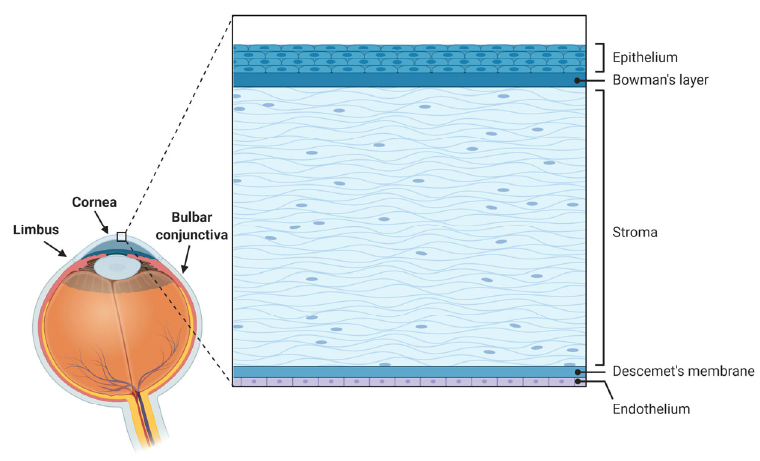
Figure 1. Anatomy of the ocular surface and histology of the human cornea and its various layers. Corneal healing, similar to other types of wound healing, is a dynamic and complex process divided into three main phases, namely inflammation (wound detersion), cell proliferation and migration (tissular regeneration), and remodeling (tissular homeostasis restoration) [6]. As the cornea is an avascular tissue, no hemostasis occurs at the early stages of healing (as is the case for other vascularized tissues), but instead, fibrinolysis allows the dissolution of fibrin released following stromal injury and regulation of extracellular matrix turnover during healing [7].